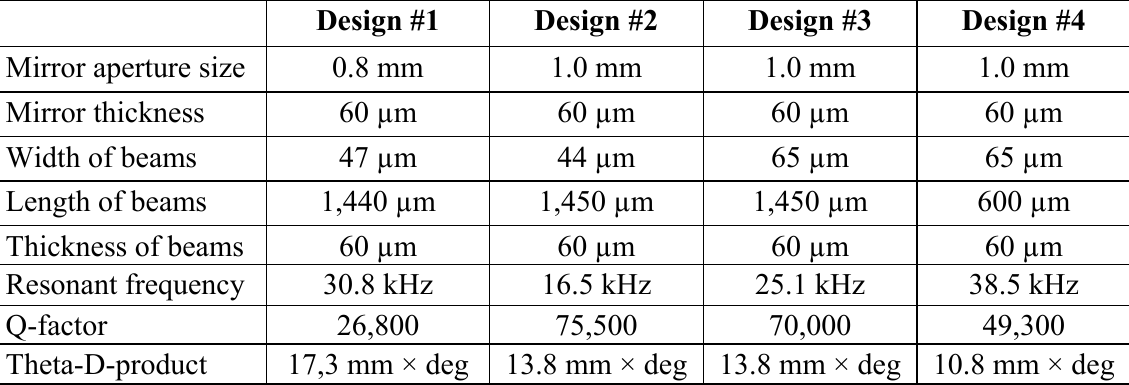
Table 3. Geometrical design data and measurement data of four different fast axis mirror resonators.